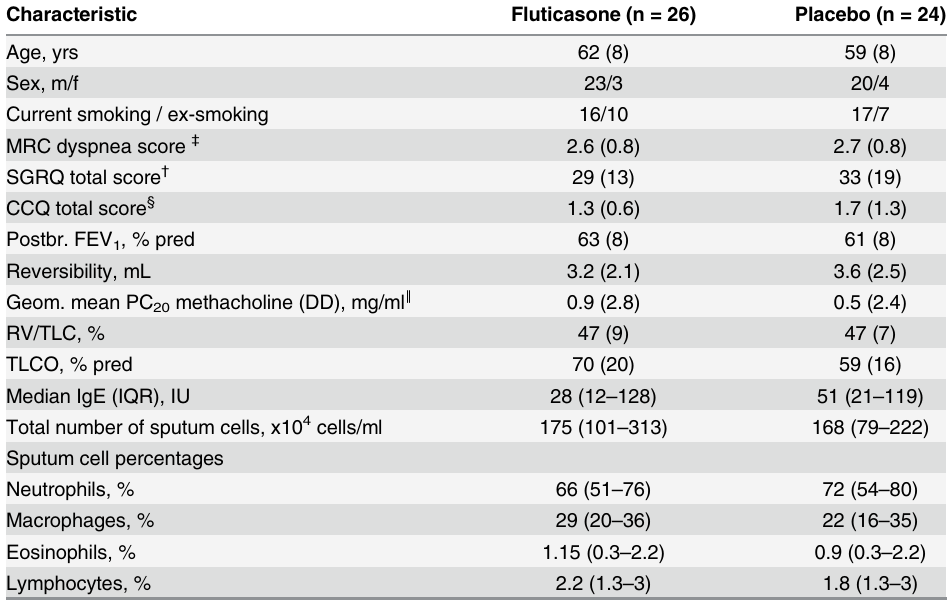
Table 2. Patient characteristics at baseline. Characteristics of the study population per treatment group at baseline. Data represent mean (SD).